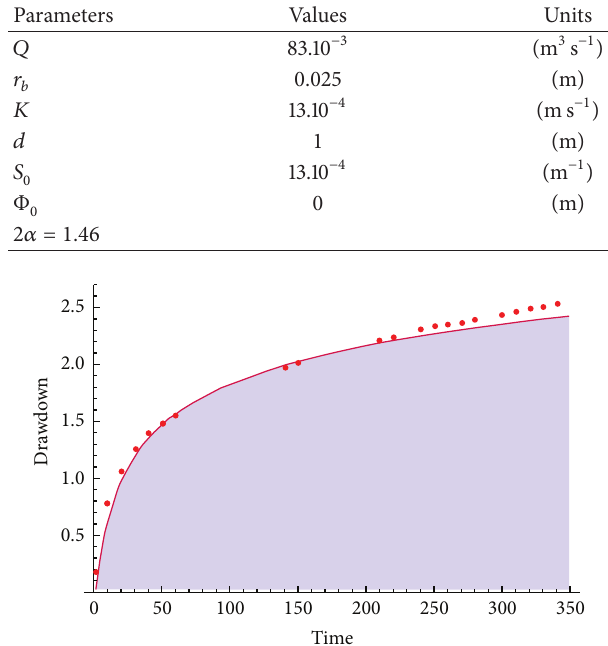
Figure 1: Comparison of experimental data from real world obser- vation with solution of fractional groundwater flow